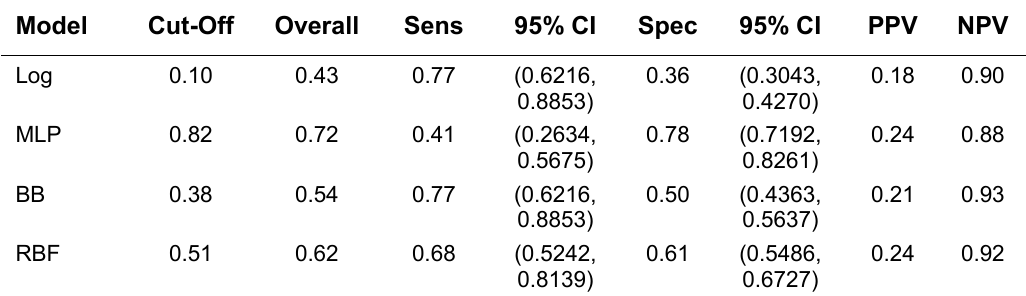
Model Performance Comparison of Sensitivity and Specificity Administrative and Clinical Data Testing Set — 90-Day Models